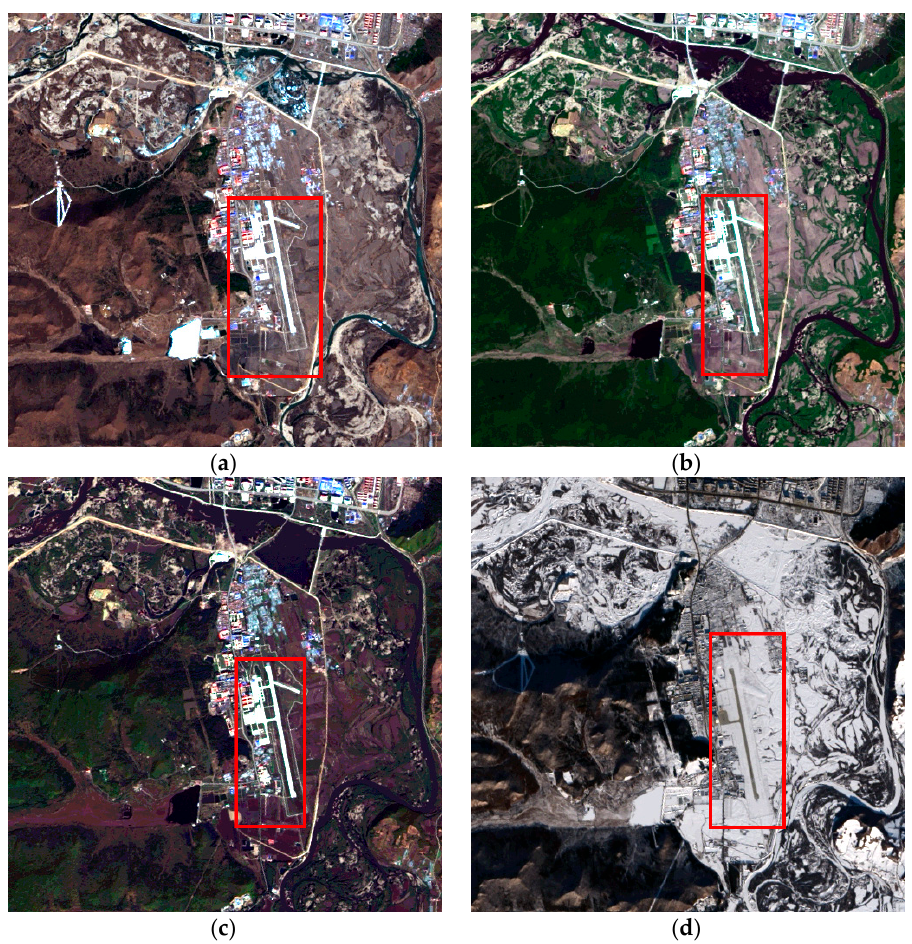
Figure 15. Detection results of the proposed method in different seasons at Jiagedaqi airport. ( a )